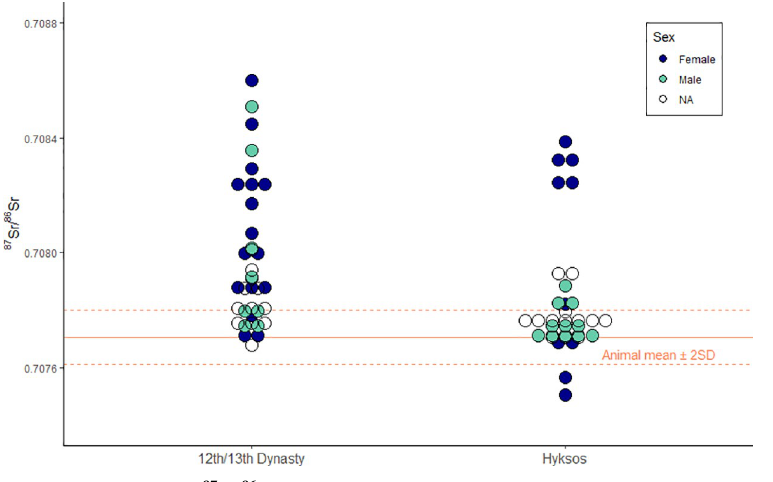
Fig 6. Dot plot showing 87 Sr/ 86 Sr results by time period, with the dots colored by sex.